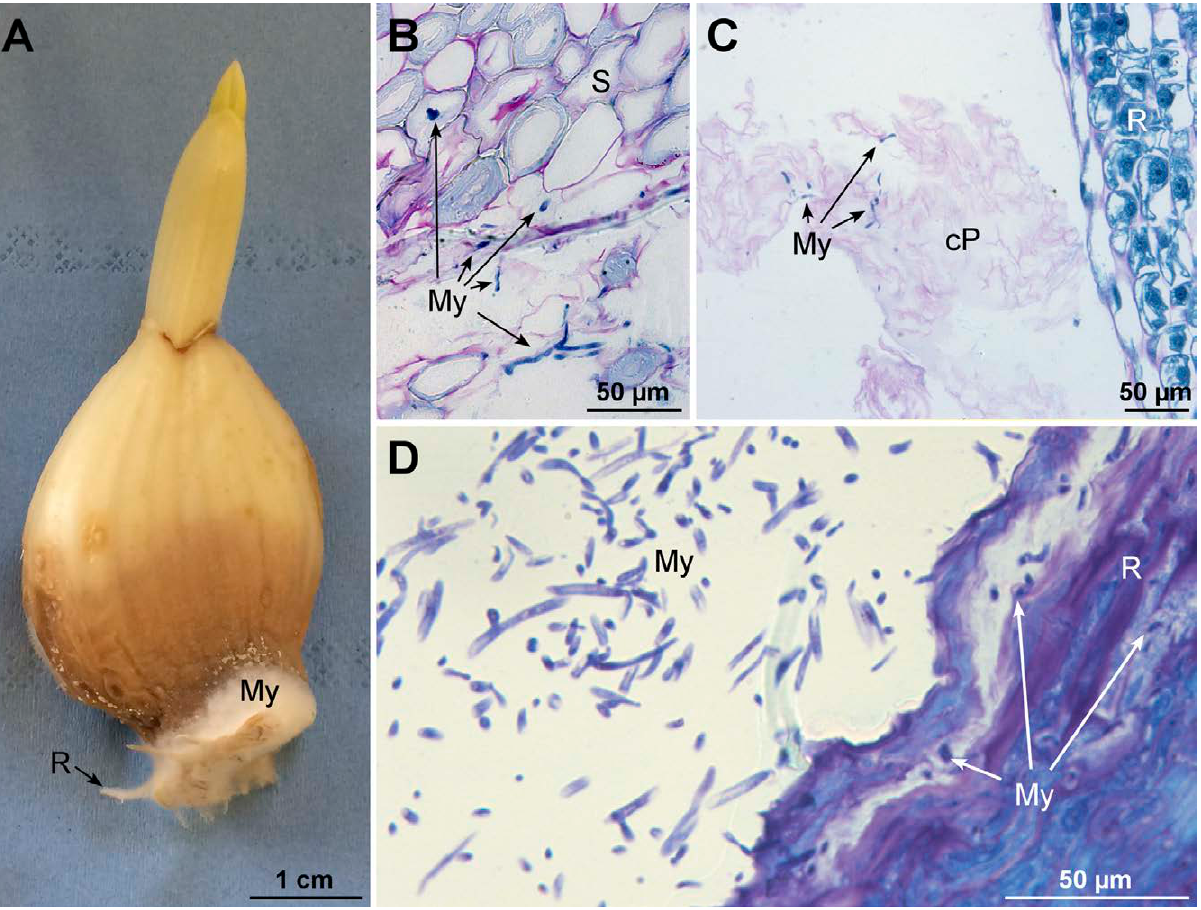
Figure 3. Morphology and cytohistological aspects of Fusarium proliferatum infected garlic cloves 48–72 h post inoculation. A, Image of an infected clove. B and C, Micrographs illustrating the progression of clove infection 48 h post inoculation. D, Detail of the decayed root tis- sue. R: roots, My: mycelium, S: thick-walled cells, cP: collapsed parenchyma cells. A, Stereomicrograph. B and C, Light micrographs after PAS/NBB staining. D, Light micrograph with TB